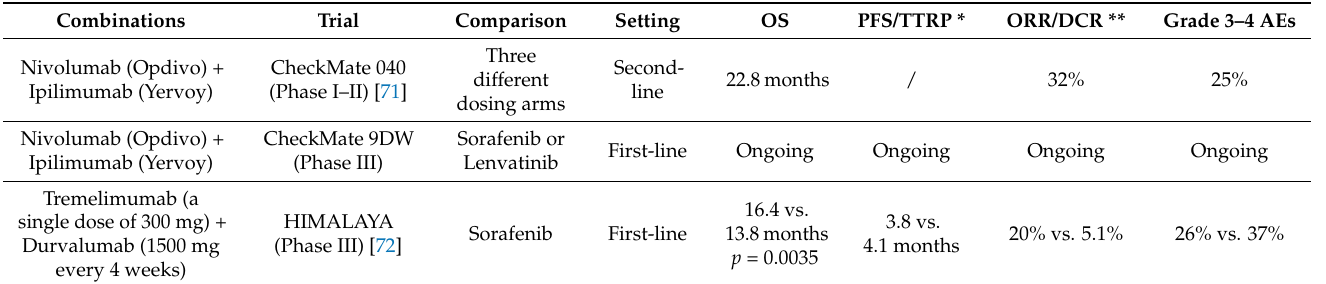
Table 3. PD-L1 inhibitors with other immunotherapies for the treatment of advanced